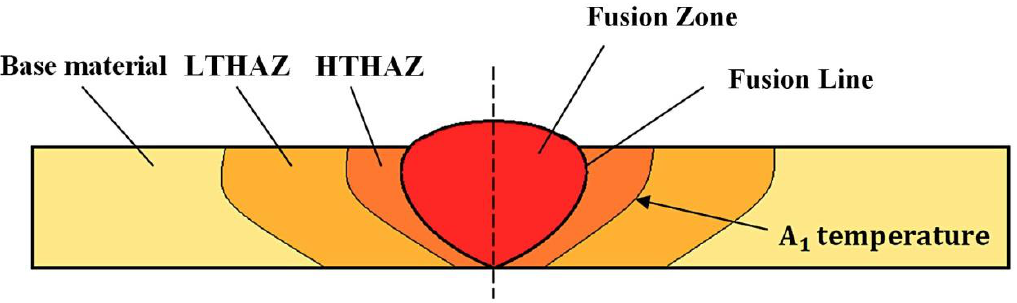
Figure 3. Scheme of the welded joint with specified zones [8].